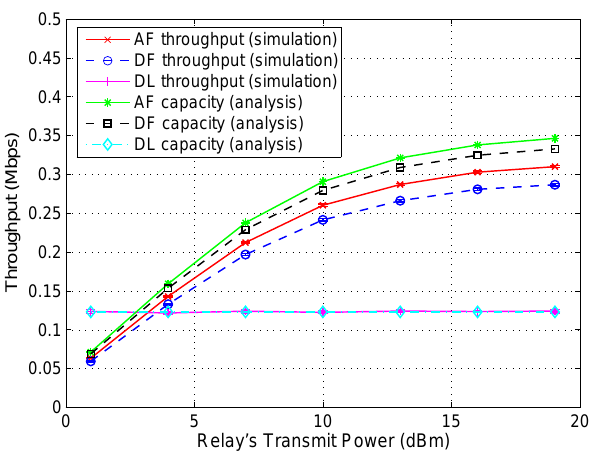
Figure 7. Throughput performance versus transmit power of relay